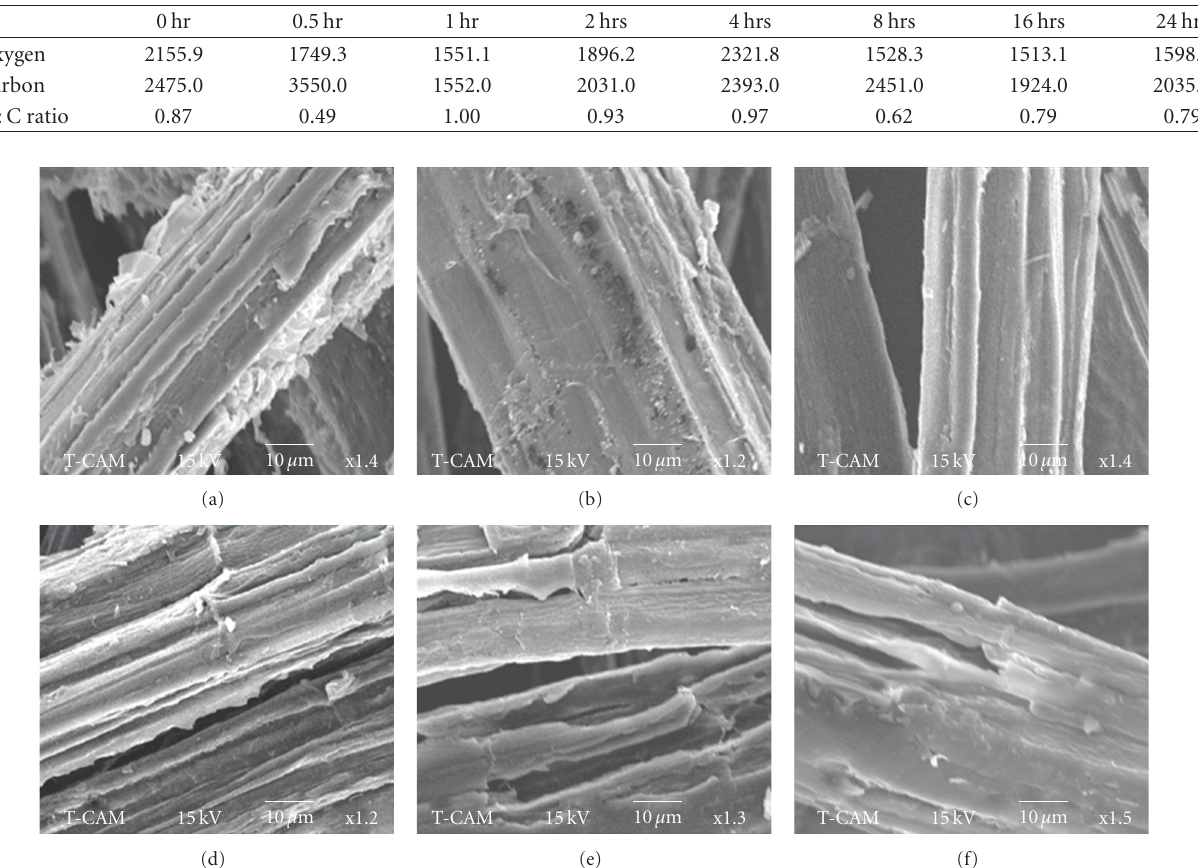
Table 1: Oxygen to carbon ratio for untreated and alkali-treated kenaf fibers.